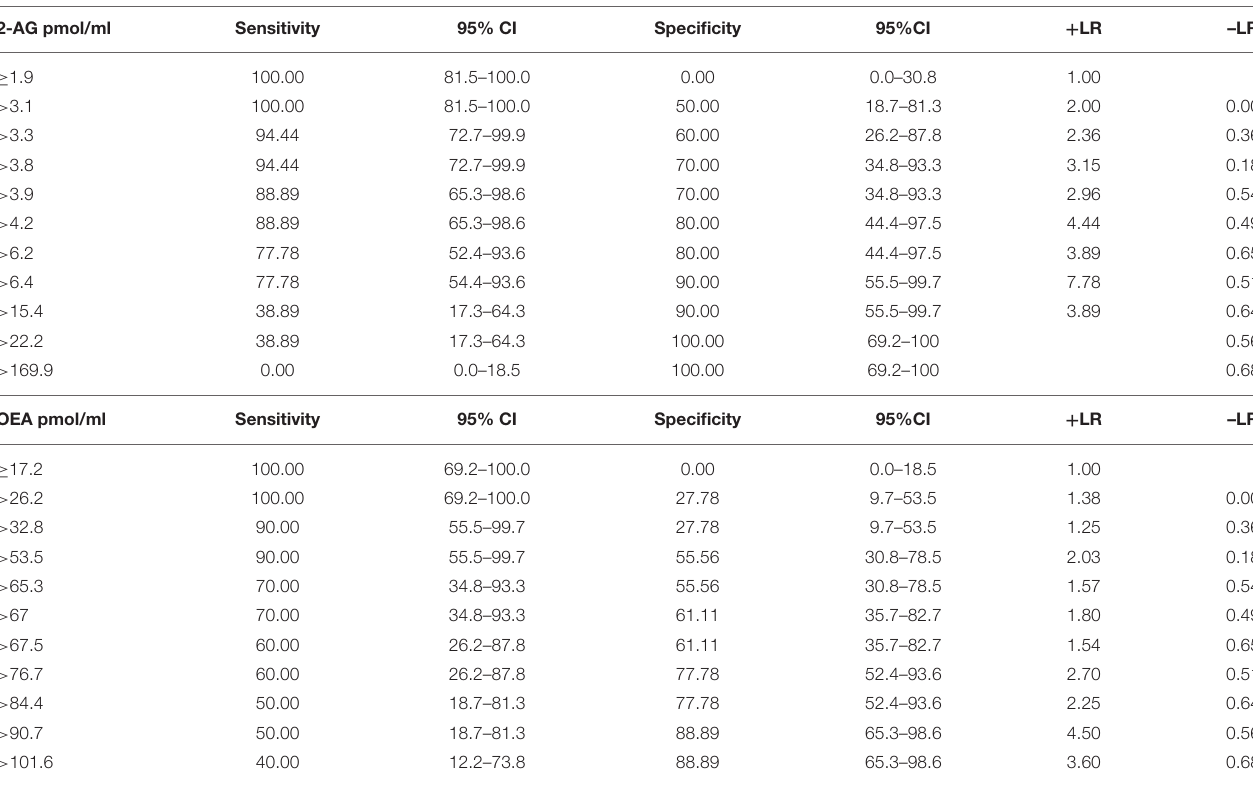
TABLE 7 | Diagnostic efficacy of 2-AG to diagnose ARE or IRE and diagnostic efficacy of OEA to diagnose FRE in dogs. 2-AG